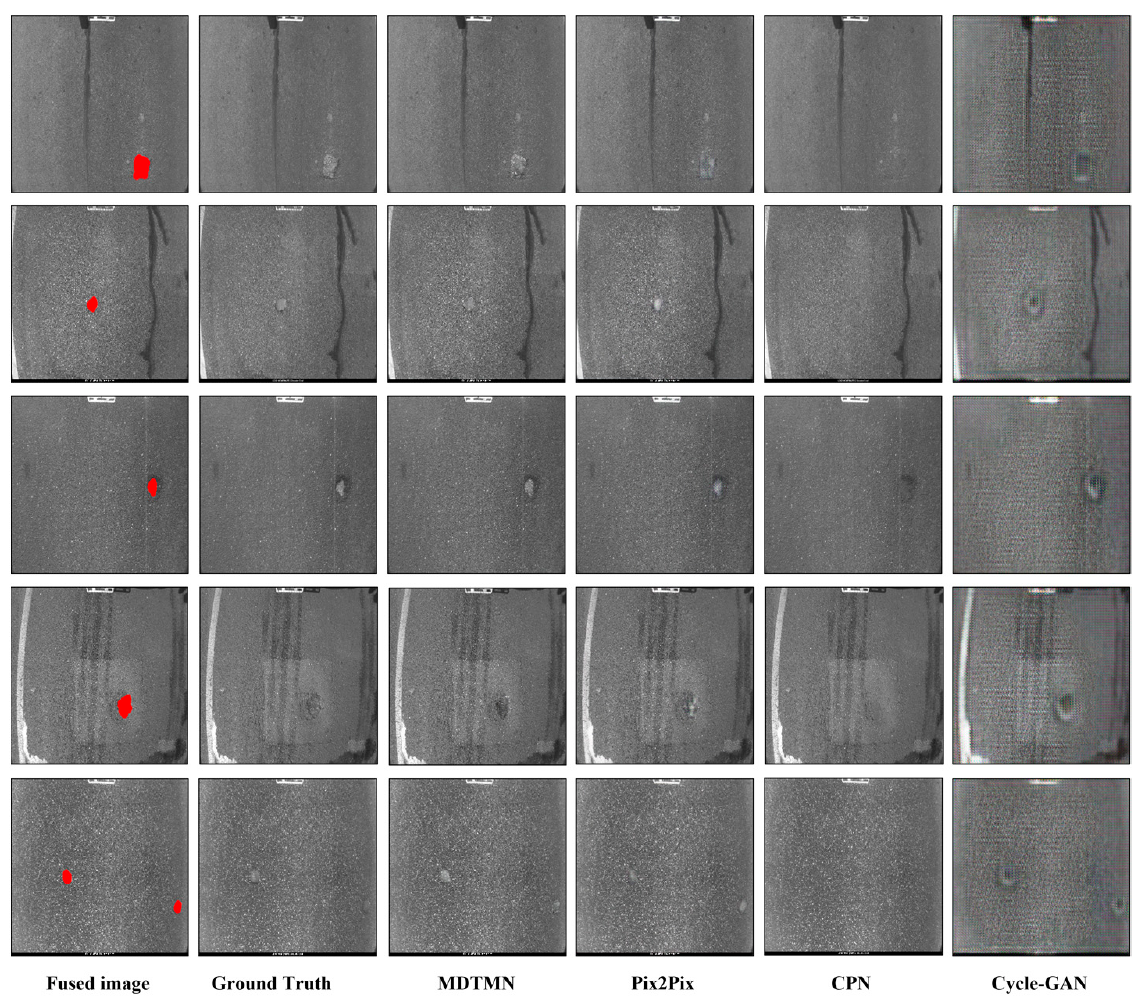
Figure 13. Pothole images generation with Ground Truth images reference. The red marks illustrate the labeled pit area.